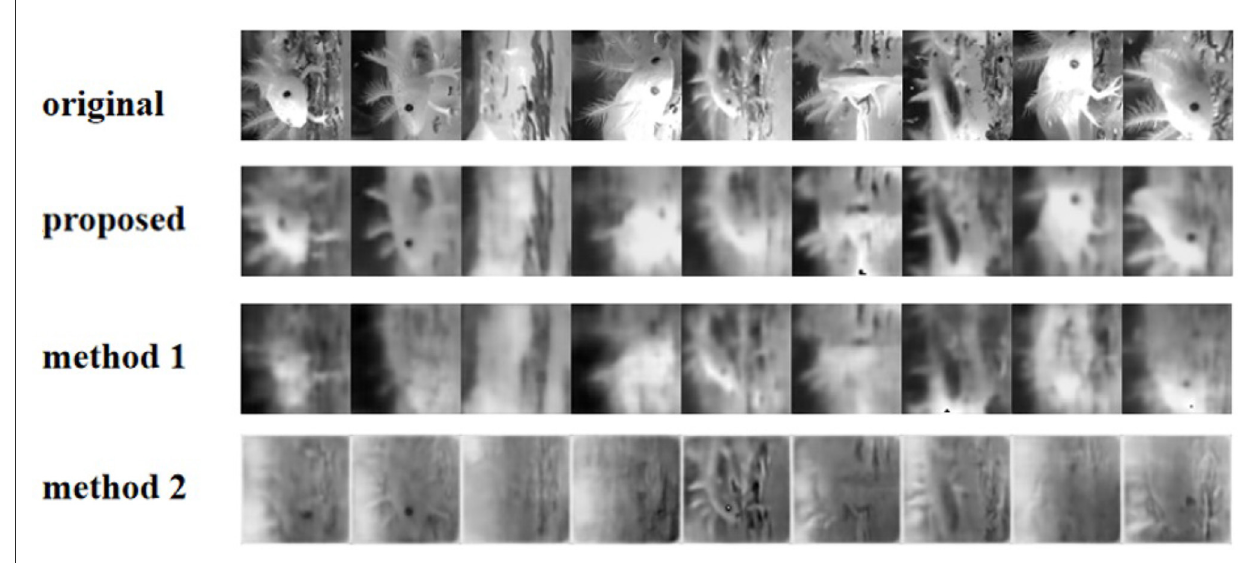
FIGURE8 Reconstruction of the video frames using different methods from V1 neurons.